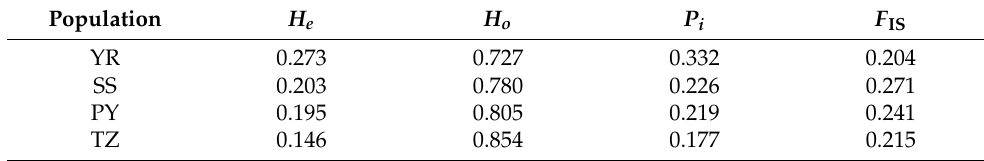
Table 2. Analysis of genetic polymorphism parameters of SNP loci in Coilia nasus populations.